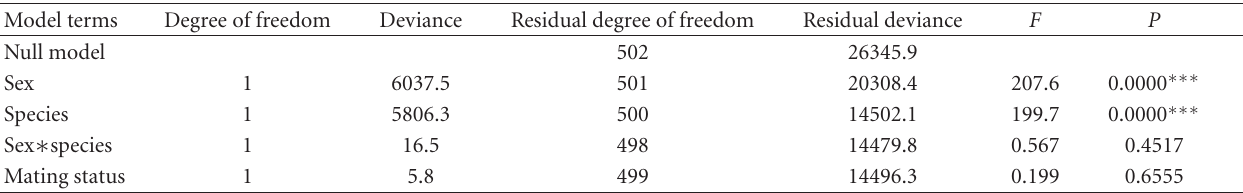
Table 1: ANOVA table of a GLM model to estimate the e ff ects of sex, species, mating status, and the interaction of sex and species on pupal weight at the time of adult